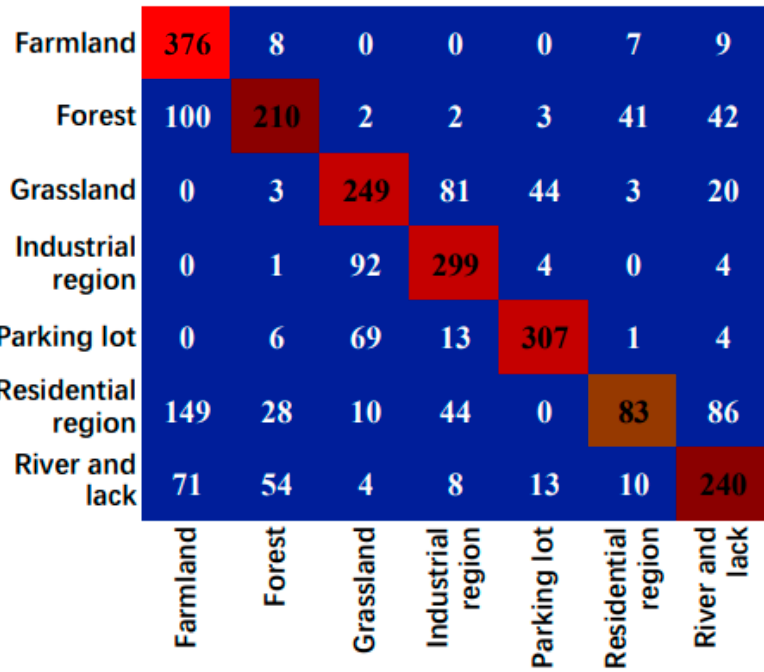
Figure 12. Figure 12. Confusion matrix of the cross-domain scene classification results for NWPU-RE- SIST45 → RSSCN7.